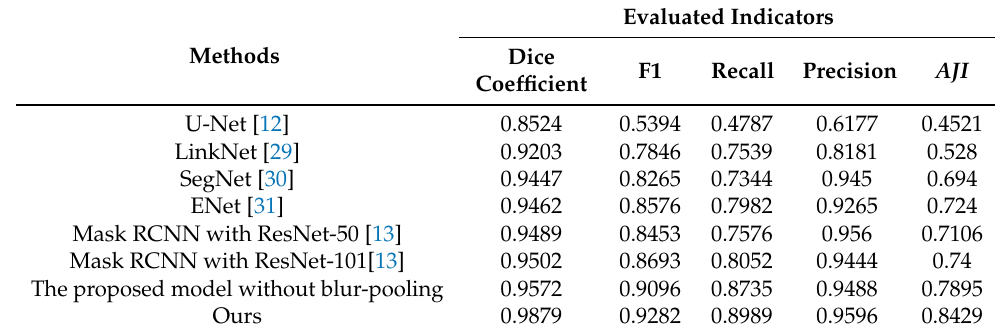
Table 3. Quantitative comparison of different methods applied to the DSB